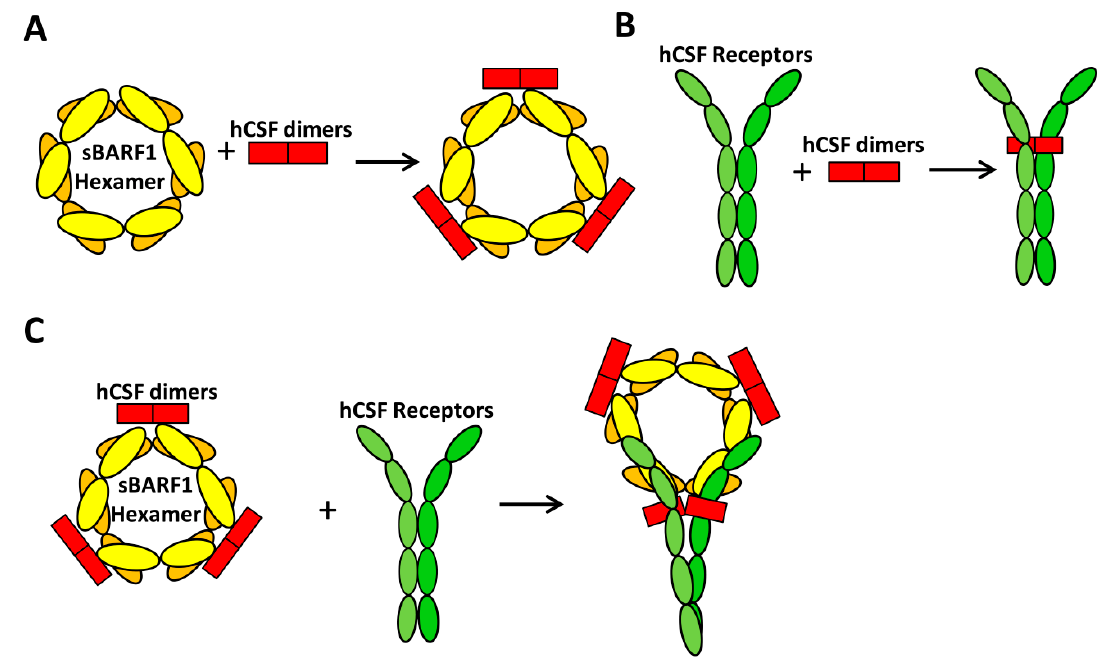
Figure 2. The binding of secreted BARF1 (sBARF1) with hCSF1 reduces the interaction of hCSF1 with its cognate receptor. ( A ) The interaction of one sBARF1 hexamer with three hCSF1 dimers. ( B ) The binding of hCSF dimers with its cognate receptor, CSF1R / CD115. ( C ) The binding of sBARF1 with hCSF1 causes an inactive conformation of hCSF1, hindering the interaction with its cognate receptor.